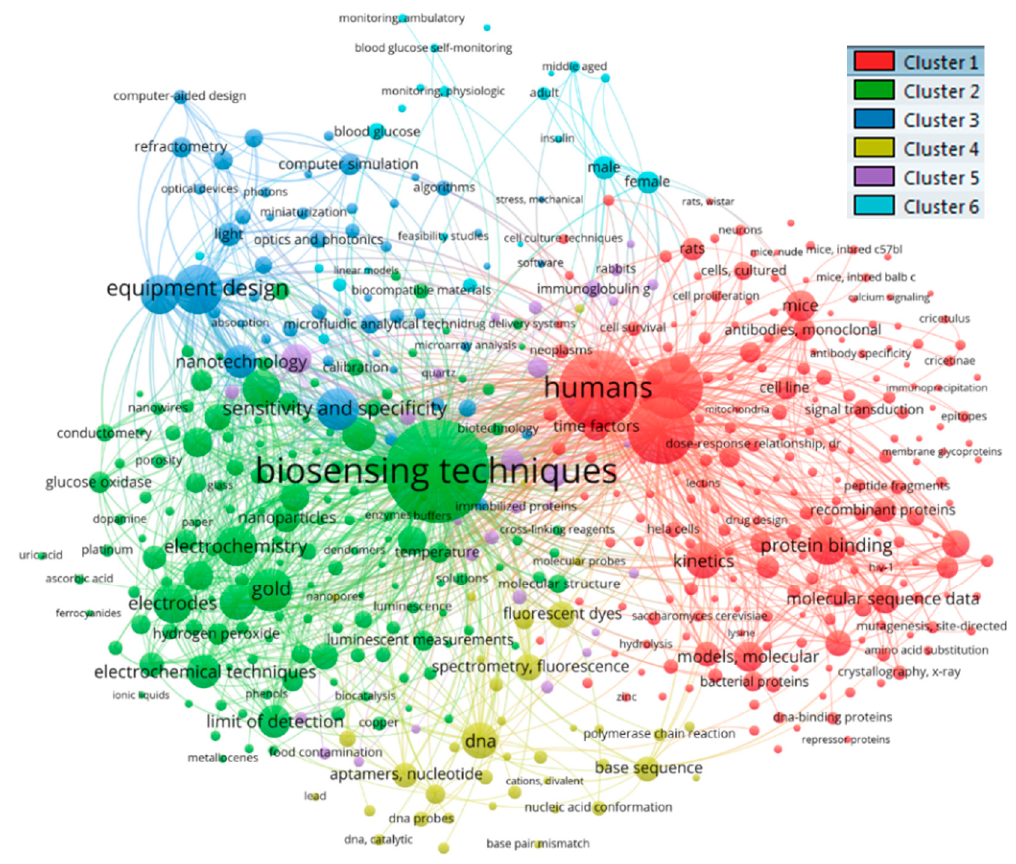
Figure 20. Co-occurrence analysis of MeSH Terms. Table 5. Top 20 terms in each of the clusters that are formed with co-occurrence analysis of MeSH